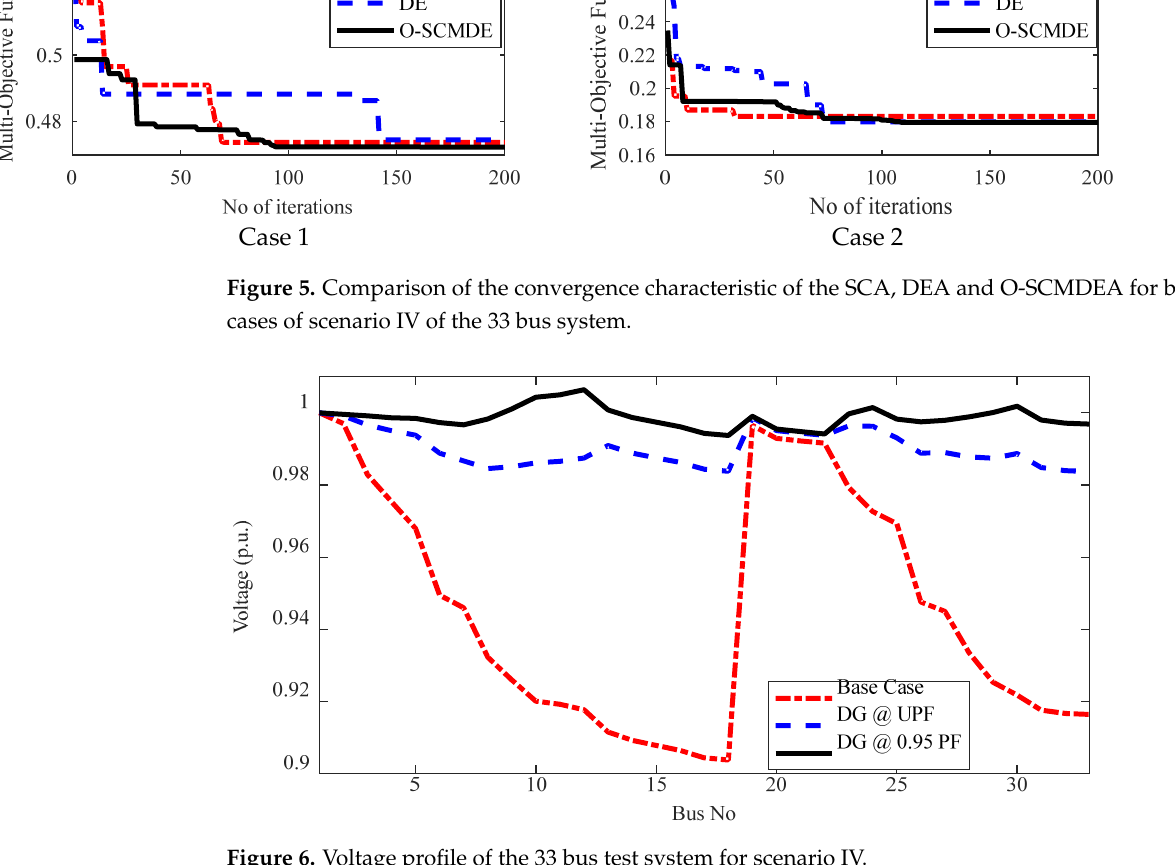
Figure 6. Voltage profile of the 33 bus test system for scenario IV.